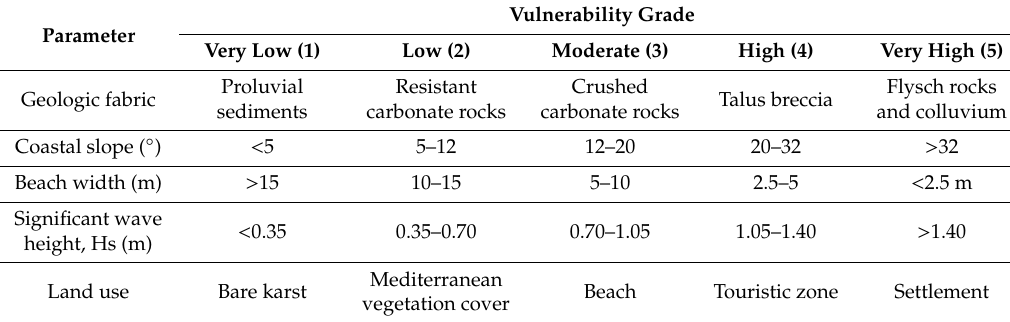
Table 1. The physical and anthropogenic parameters considered in the vulnerability analysis around Stara